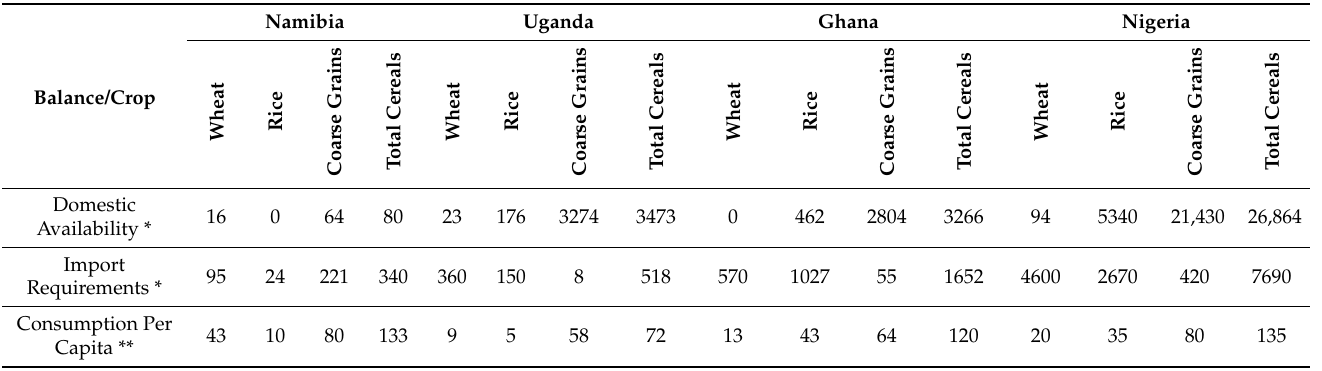
Table 1. Cereal supply/demand balance for the 2019 marketing year in Ghana, Nigeria, Uganda, and Namibia.